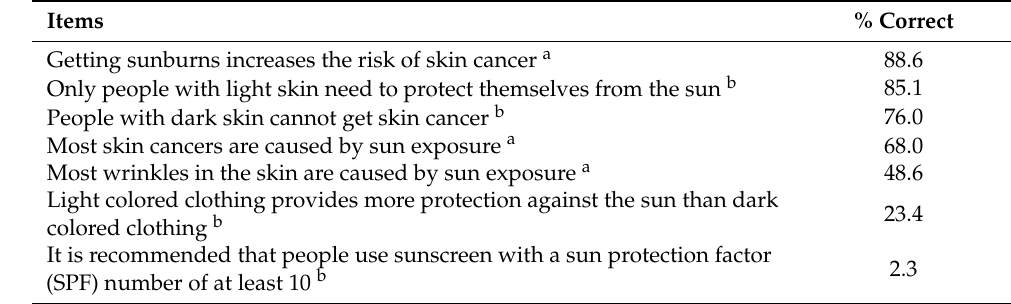
Table 2. Knowledge of sun protection and skin cancer.